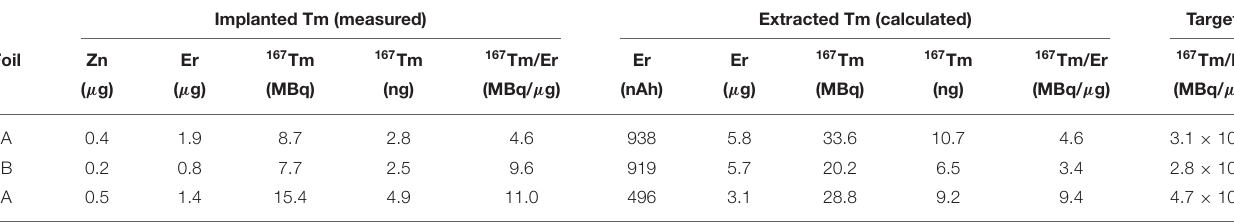
TABLE 5 | Erbium and zinc remaining traces in the mass separated samples. Implanted Tm (measured) Extracted Tm (calculated)